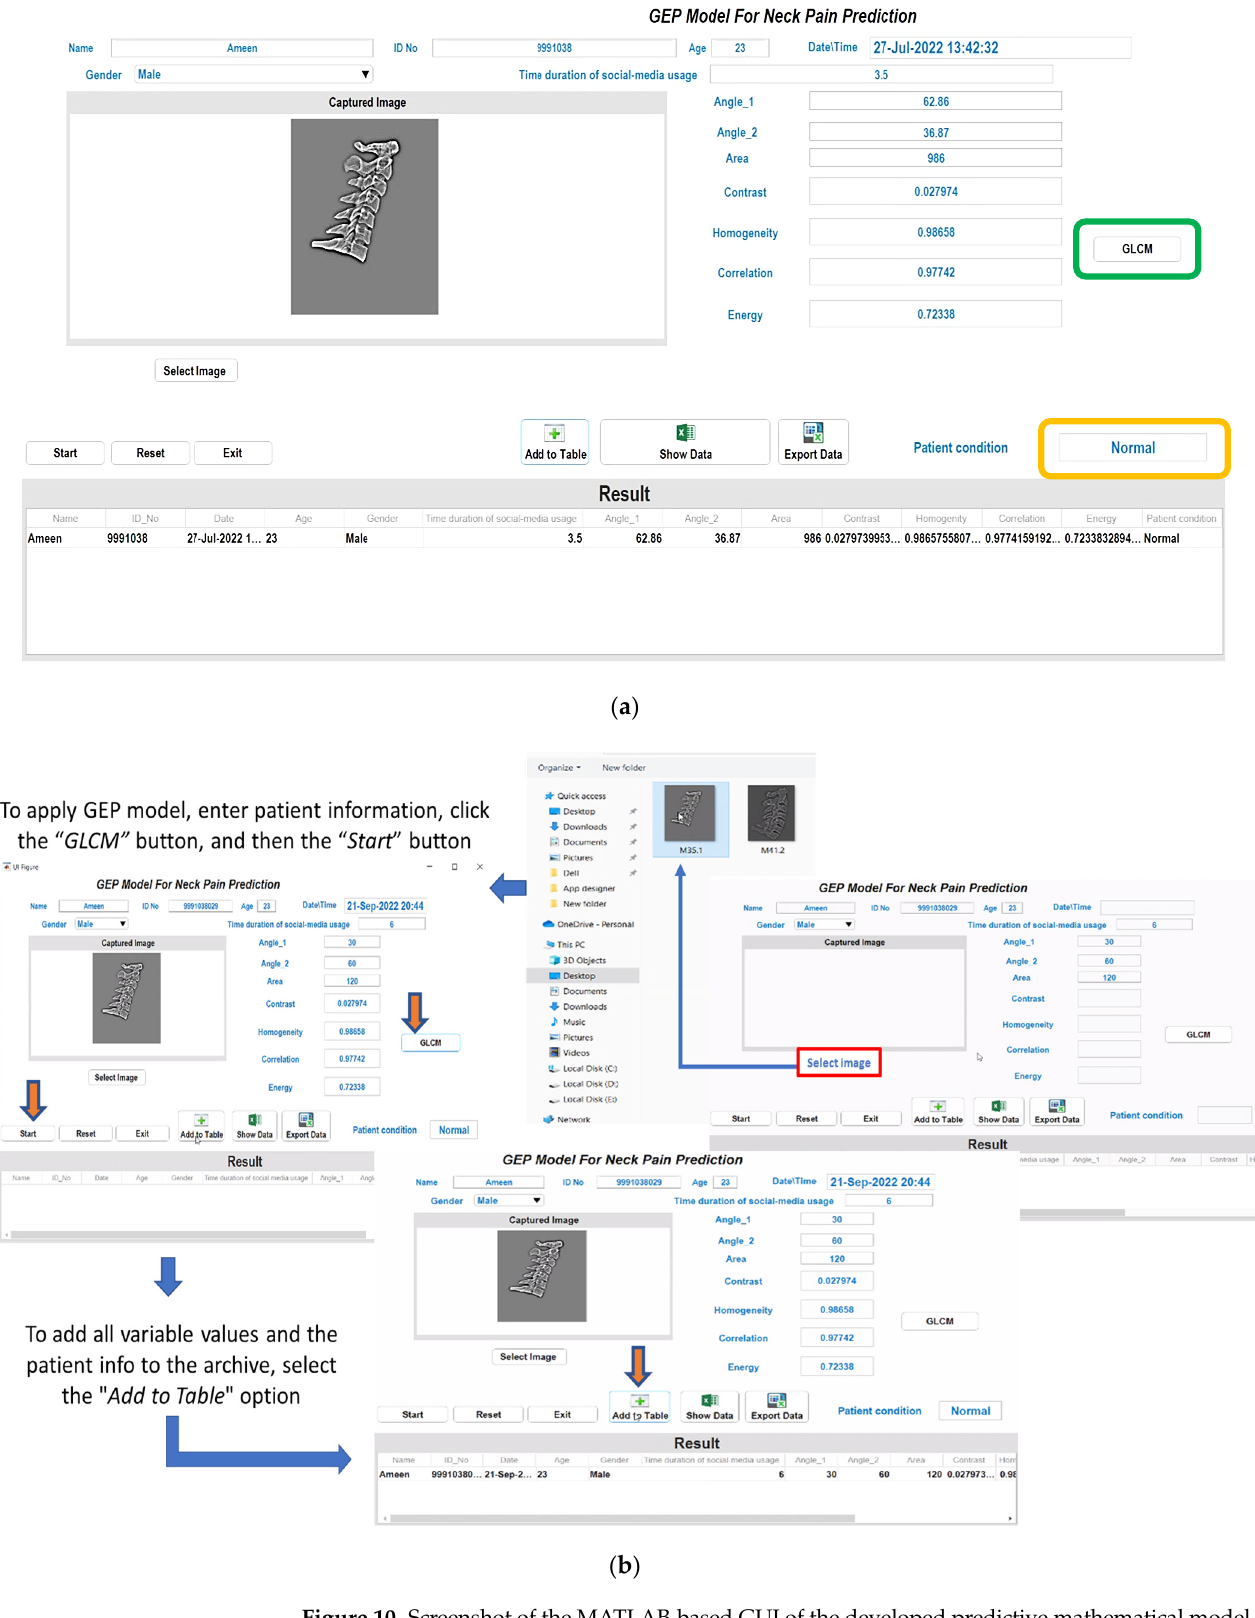
Figure 10. Screenshot of the MATLAB-based GUI of the developed predictive mathematical model ( a ); the operation procedure of the MATLAB application with indicated the various phases that follow one another ( b ).